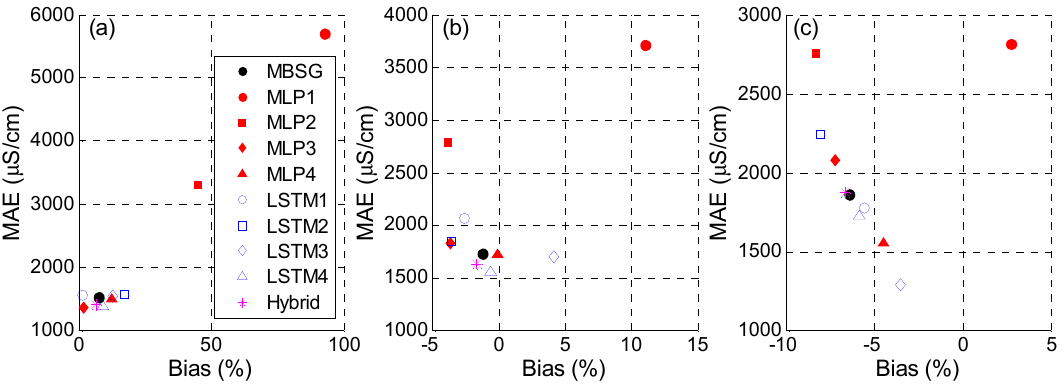
Figure 6. Percent bias (Bias; horizontal axis) and mean absolute error (MAE; vertical axis) between reference and simulated salinity at Martinez via different models grouped in three salinity ranges including ( a ) low salinity range; ( b ) medium salinity range; and ( c ) high salinity range.